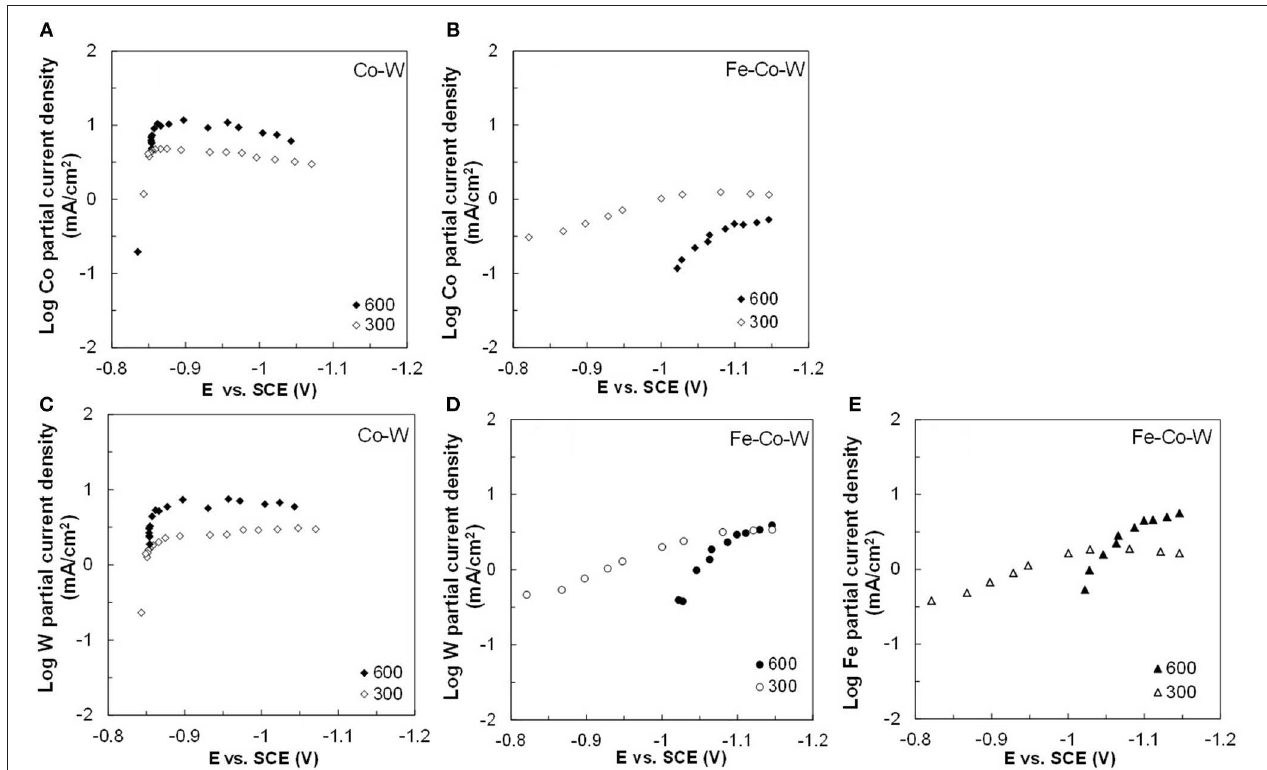
FIGURE 7 | Partial current densities (A,B) Co, (C,D) W, and (E) Fe in Co–W and Fe–Co–W electrolytes at 60 ◦ C and at an electrode rotation rates of 300 and 600 rpm.